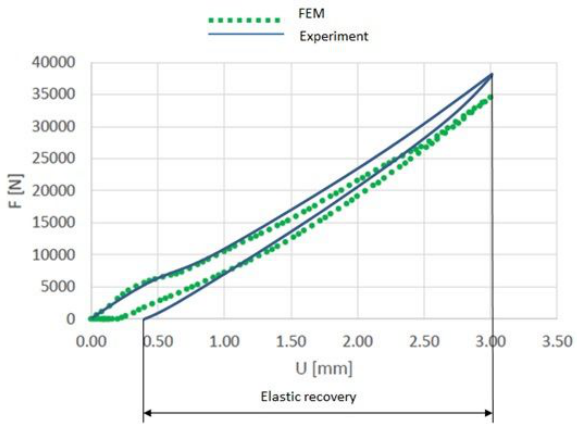
Figure 13: Characteristics of the gasket’s stiffness